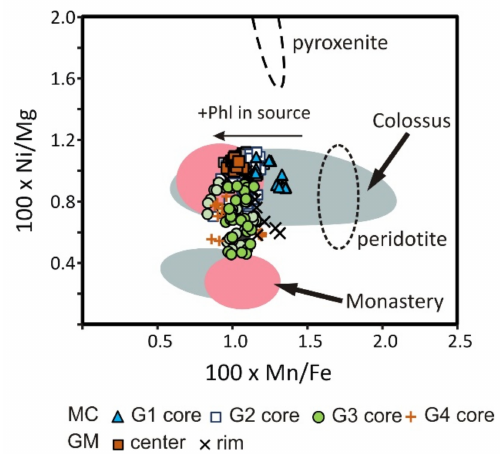
Figure 11. 100 × Ni/Mg vs. 100 × Mn/Fe for olivine macrocrysts and groundmass olivines from the Terina complex. The compositional fields of olivine megacrysts from Monastery and Colossus kimberlites [22,46,59] and the compositional fields of olivines from peridotite-derived melts and pyroxenite-derived melts [66] are given. Legend as in Figure